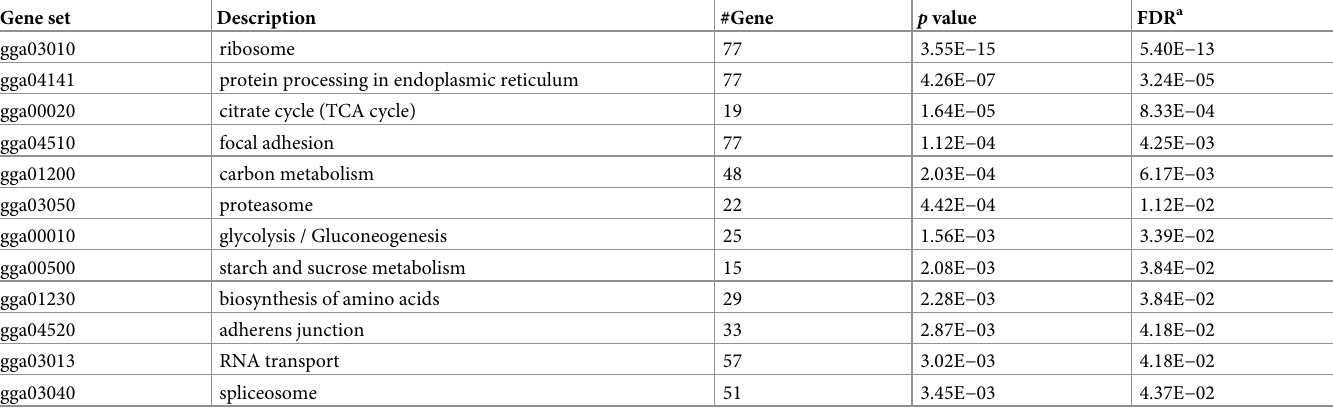
Table 10. KEGG overrepresentation analysis of differentially spliced genes.